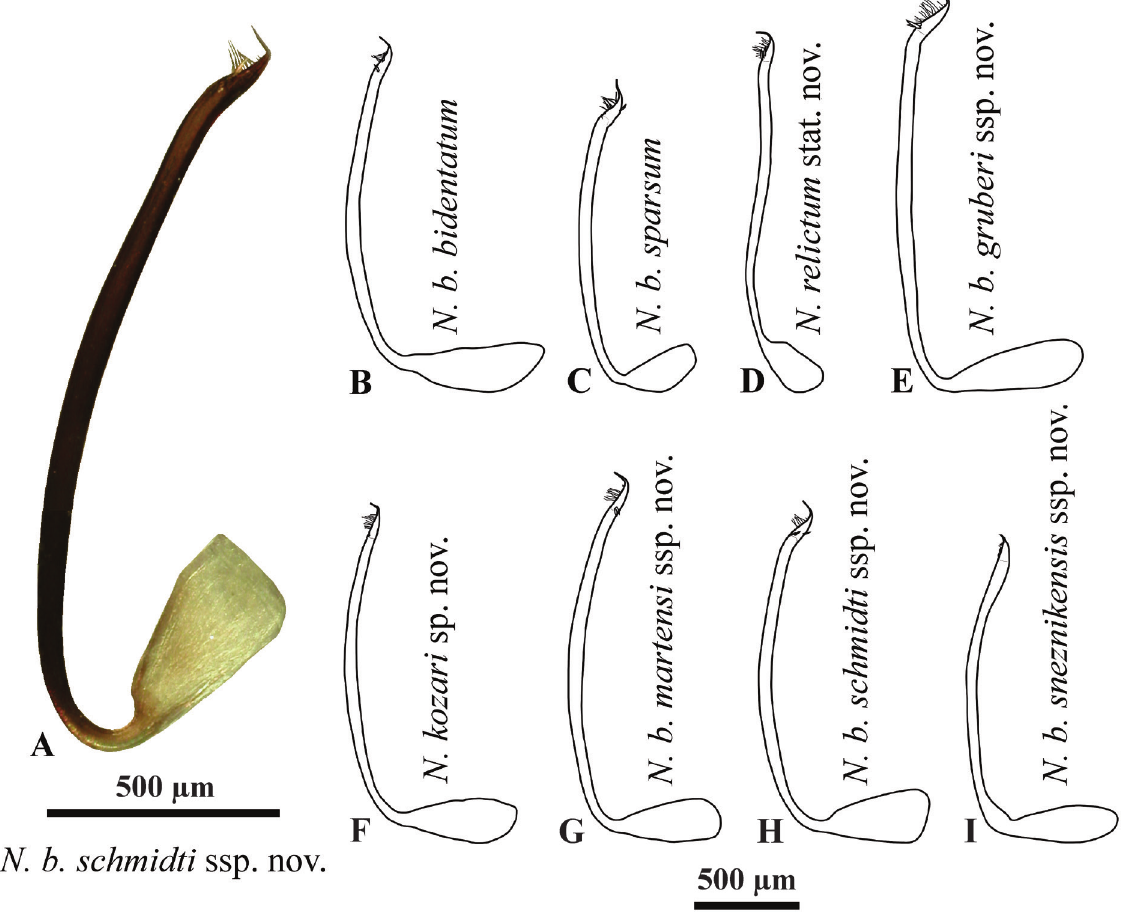
Fig. 7. Nemastoma bidentatum Roewer, 1914 complex. Penes (lateral view). Note: The penis of N. pluridentatum (Hadži, 1973) stat. nov. is